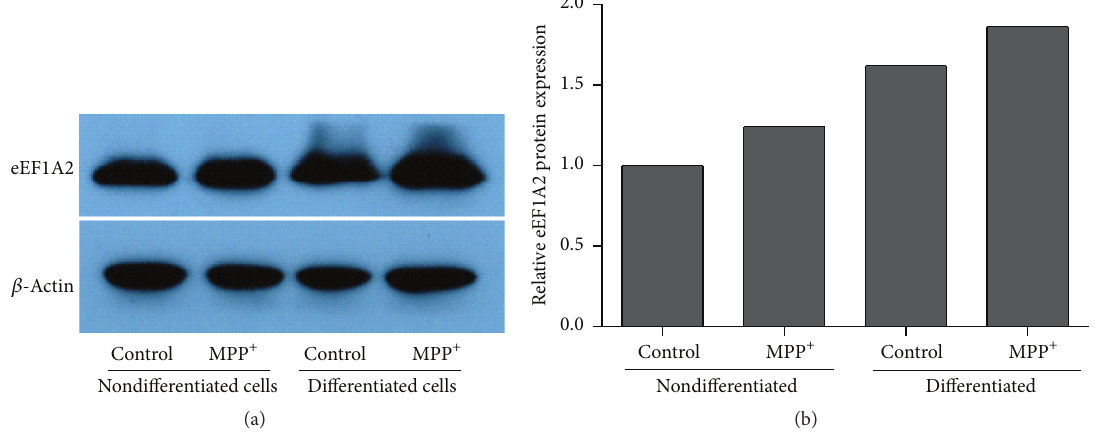
Figure 4: Relative protein expression of eEF1A2 in nondifferentiated and differentiated SH-SY5Y cells by Western blot (a). For neuronal differentiation, SH-SY5Y cells were treated with 10 𝜇 M retinoic acid for three days before exposure to MPP + . The control groups for nondifferentiated and differentiated SH-SY5Y cells were treated with the same medium without MPP + . (b) represents the quantification of the band density normalized to actin, relative to a nondifferentiated